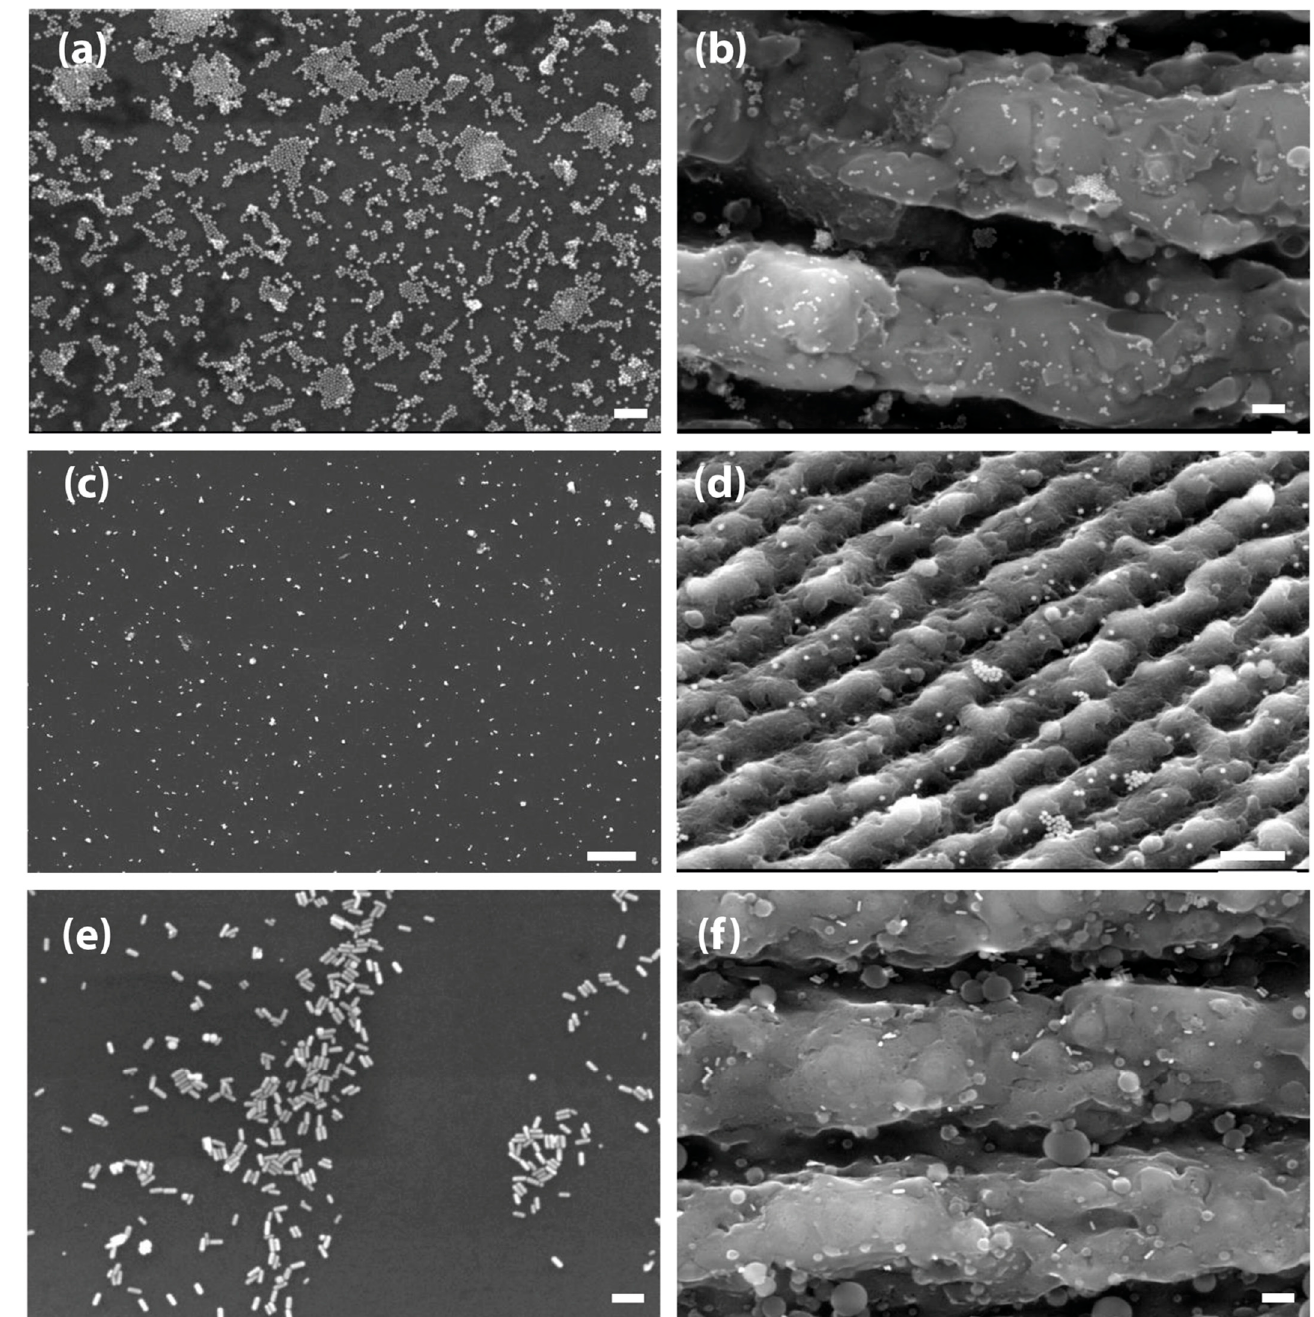
Figure 3. SEM images of spherical Au NPs with 13 nm size diameter, covalently bound onto flat ( a ) and nanopatterned Si substrates ( b ) (scale bars: 100 nm) diluted in 40% ethanol; spherical Au NPs with 80 nm diameter, covalently bound onto flat ( c ) and nanopatterned ( d ) Si substrates (scale bars: 1 µm) deposited via drop evaporation protocol diluted in 40% of ethanol; rod-shaped with 53 nm length Au NPs and aspect ratio 3:1, covalently bound onto flat ( e ) and nanopatterned ( f ) Si substrates (scale bar: 100 nm) deposited via drop evaporation protocol diluted in 40% of ethanol.